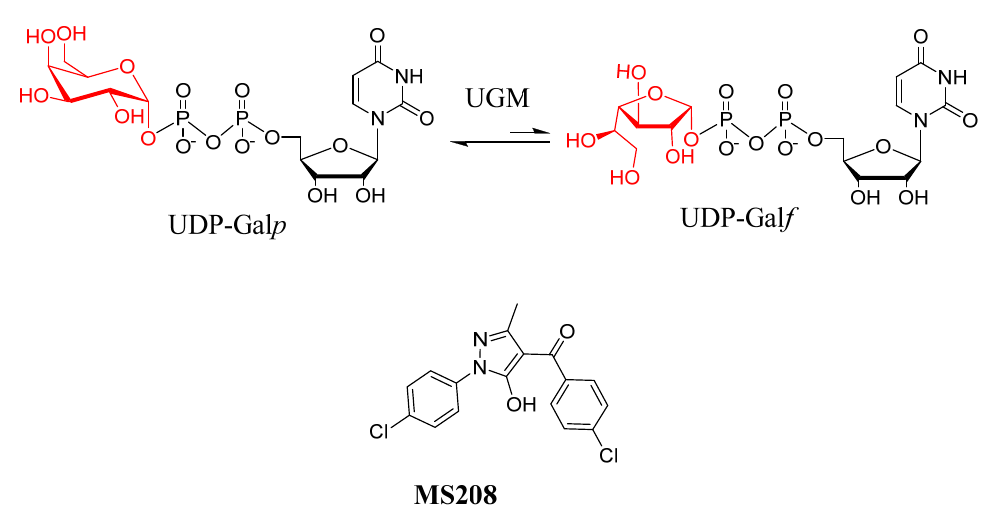
Figure 1. Reaction catalyzed by UGM by forming UDP-Gal f from UDP-Gal p , and the chemical structure of MS208.